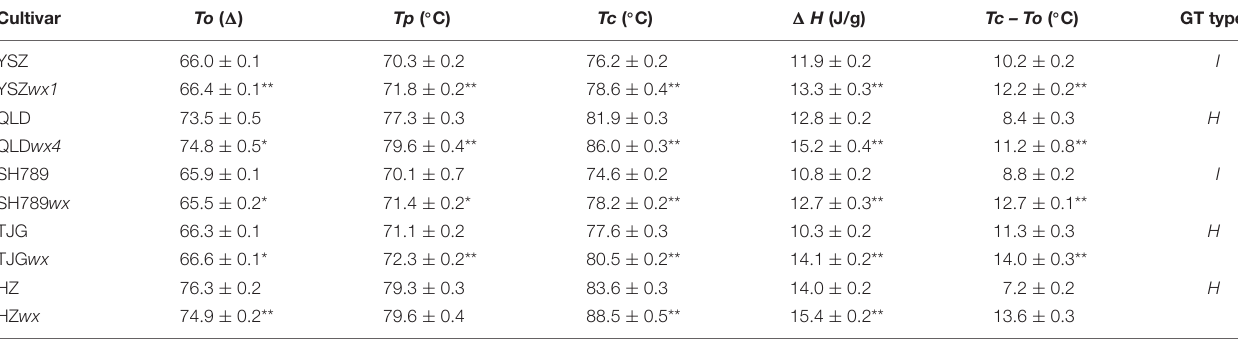
TABLE 1 | Differential scanning calorimetry (DSC) and enthalpy ( (cid:49) H ) values of wx mutants and their corresponding WTs. Cultivar To ( (cid:49) ) Tp ( ◦ C) Tc ( ◦ C) (cid:49) H (J/g) Tc – To ( ◦ C) YSZ 66 . 0 ± 0 .